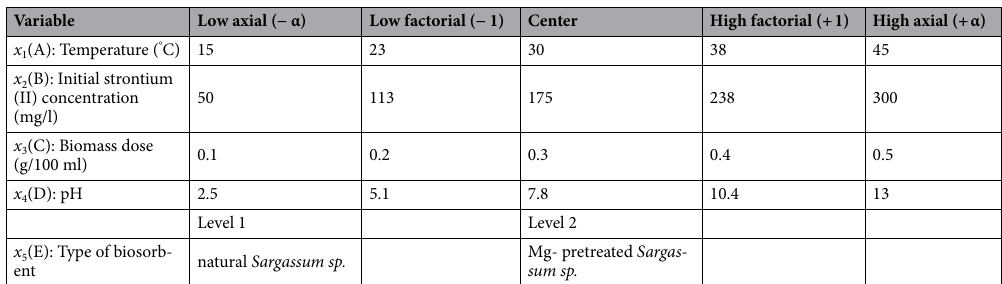
Table 1. The experimental range and levels of the control factors in the CCD. *α =